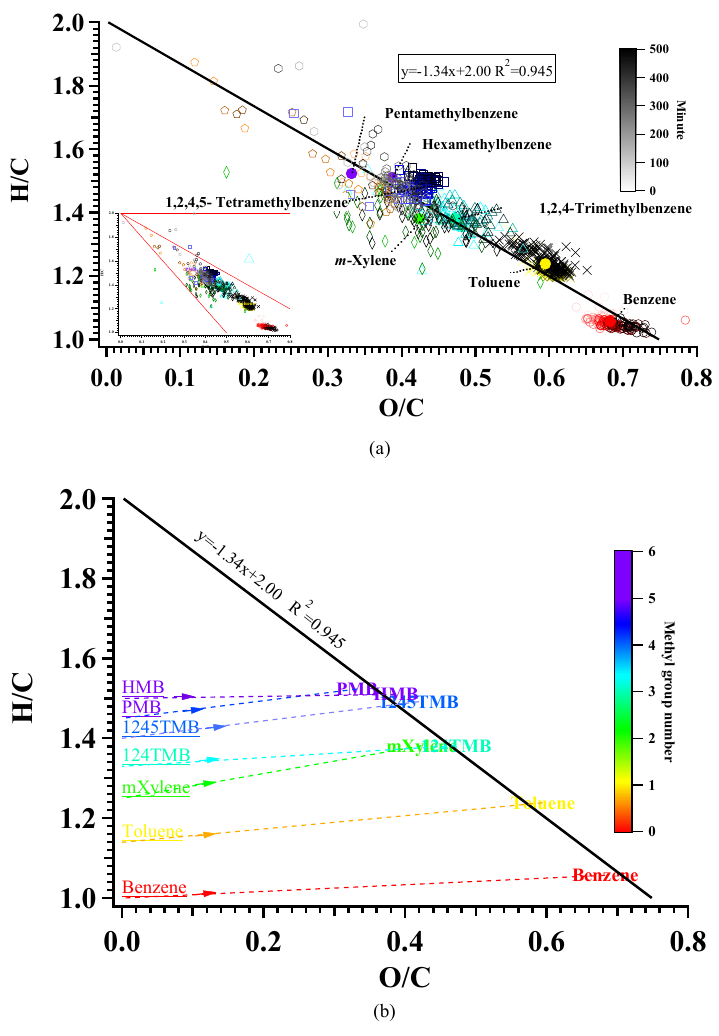
Figure 3. (a) H/C and O/C evolution; the inset graph shows the measured values relative to the classic triangle plot (Ng et al., 2010). (b) Average H/C and O/C in SOA formed from monocyclic aromatic hydrocarbon photooxidation under low NO x (benzene 1223A; toluene 1468A; m -xylene 1191A; 1,2,4-trimethylbenzene 1119A; 1,2,4,5-tetramethylbenzene 2085A; pentamethylbenzene 1627A; hexam- ethylbenzene